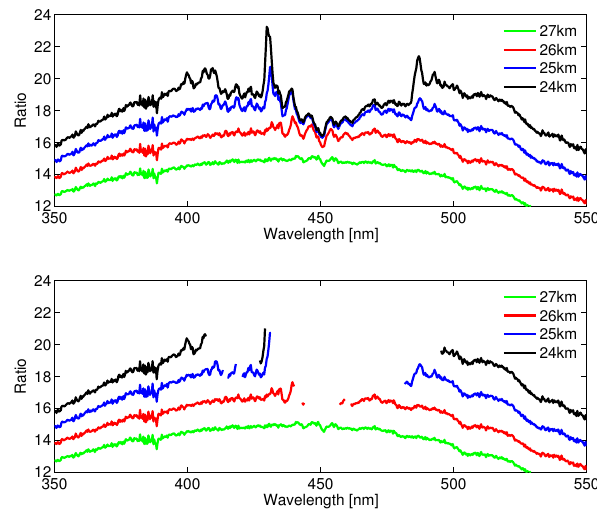
Fig. 1. Saturation in the normalized GOMOS radiances for a few altitudes. Upper panel: current Level 1 version, where obviously saturated pixels are not flagged. Lower panel: forthcoming Level 1 version including improved saturation flags (data achieved via pri- vate communications with Gilbert Barrot,